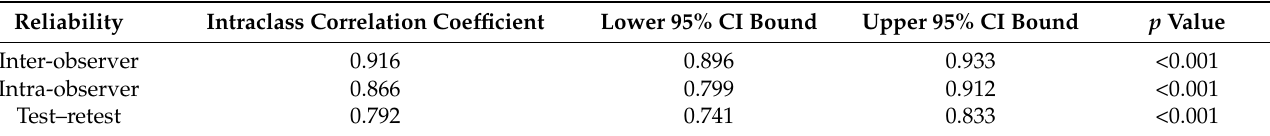
Table 5. Reliability indices of the BUT